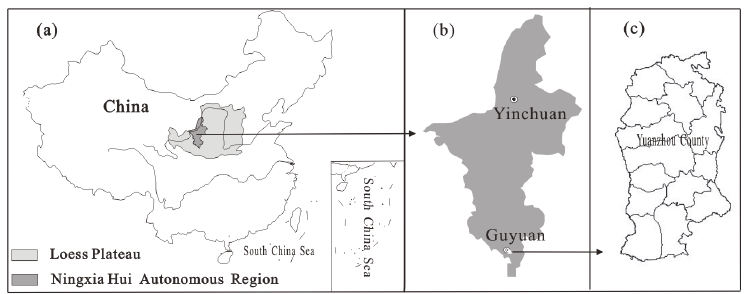
Fig 1. Site maps: (a) the location of Ningxia Hui Autonomous Region and the Loess Plateau, China; (b) the location of Yuanzhou County within Ningxia Hui Autonomous Region; (c) outlines of the administrative divisions of Yuanzhou County